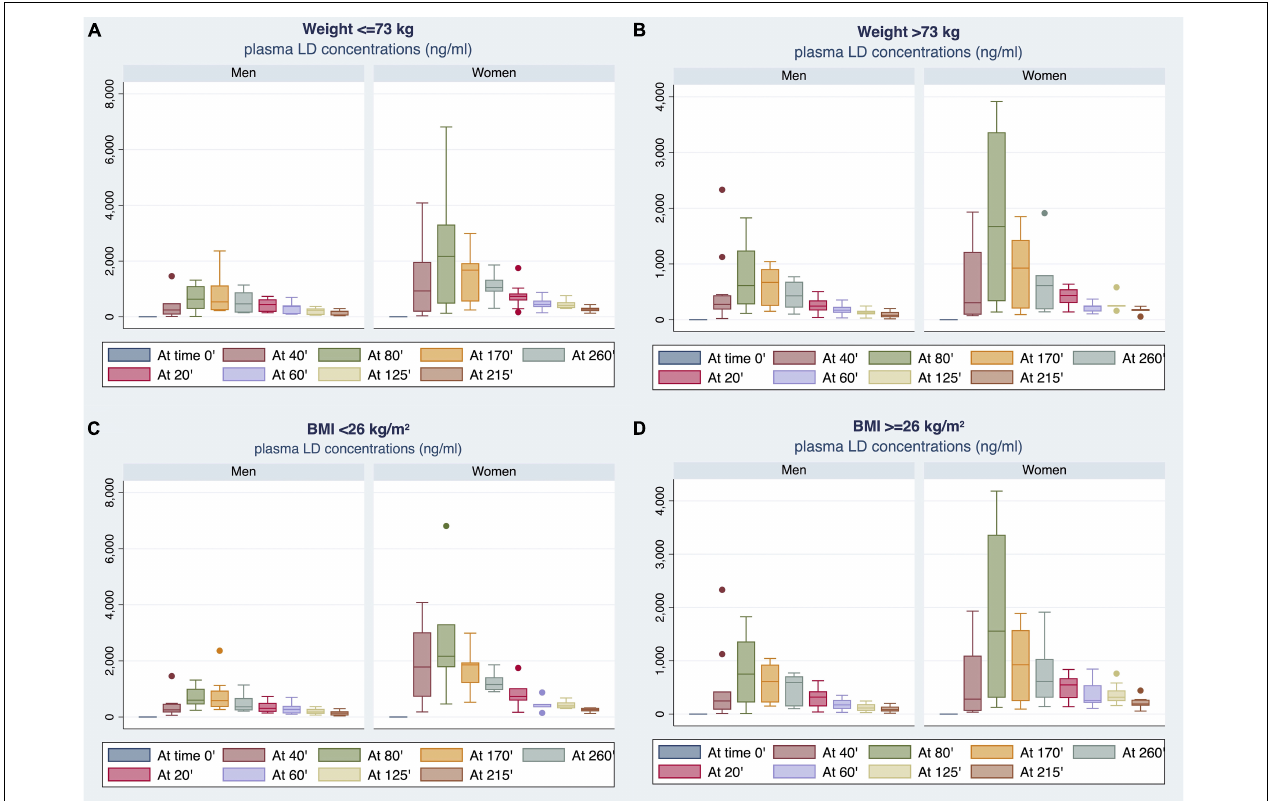
FIGURE 5 | Gender differences observed in plasma LD concentrations by stratifying the study population according to median BW (A,B) or body mass index (BMI) (C,D) values.